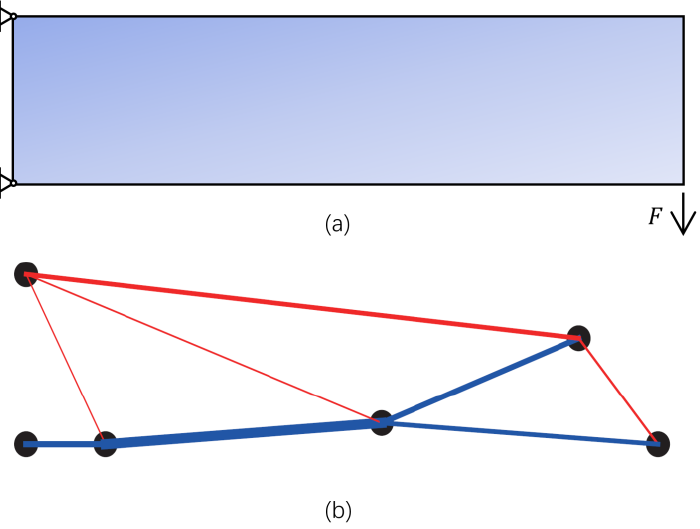
Figure 1. Layout design example of a cantilever truss. ( a ) Design domain, load and support condi- tions; ( b ) one possible layout design solution.